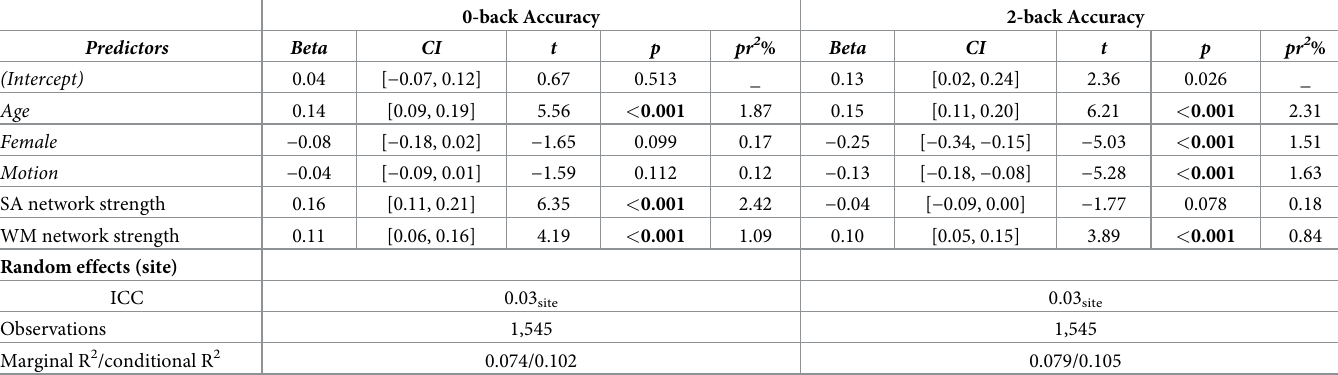
Table 1. Strengths of both SA and WM networks as predictors of task